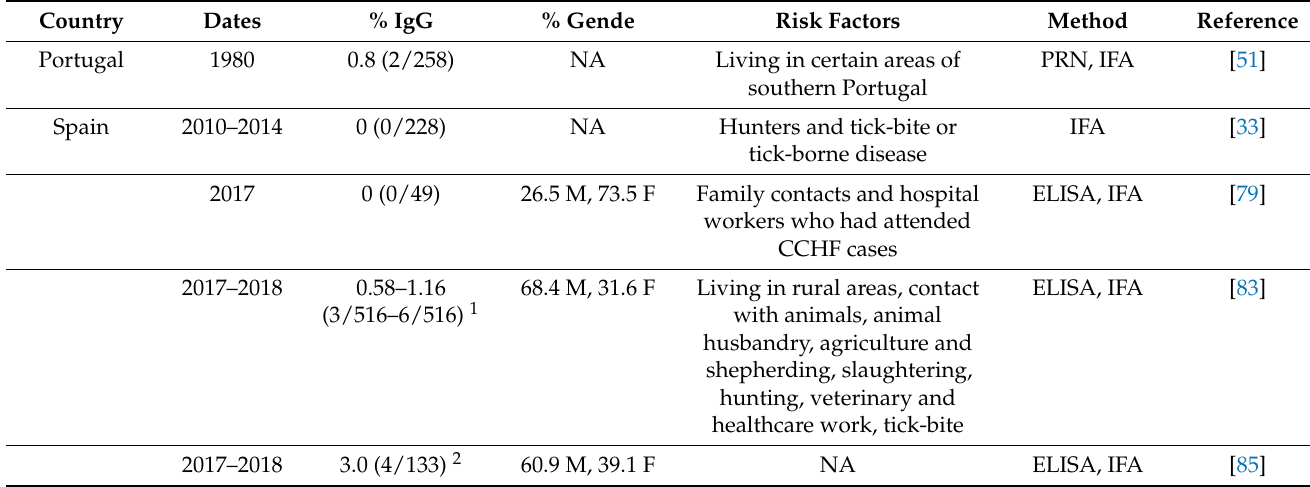
Table 4. Seroprevalence of Crimean-Congo hemorrhagic fever virus (CCHFV) in humans in western Europe. Country